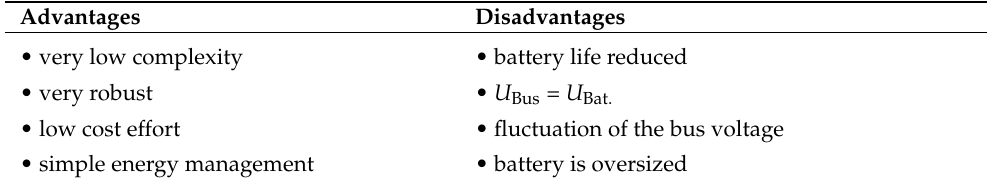
Table 8. Advantage and disadvantages Topology I.